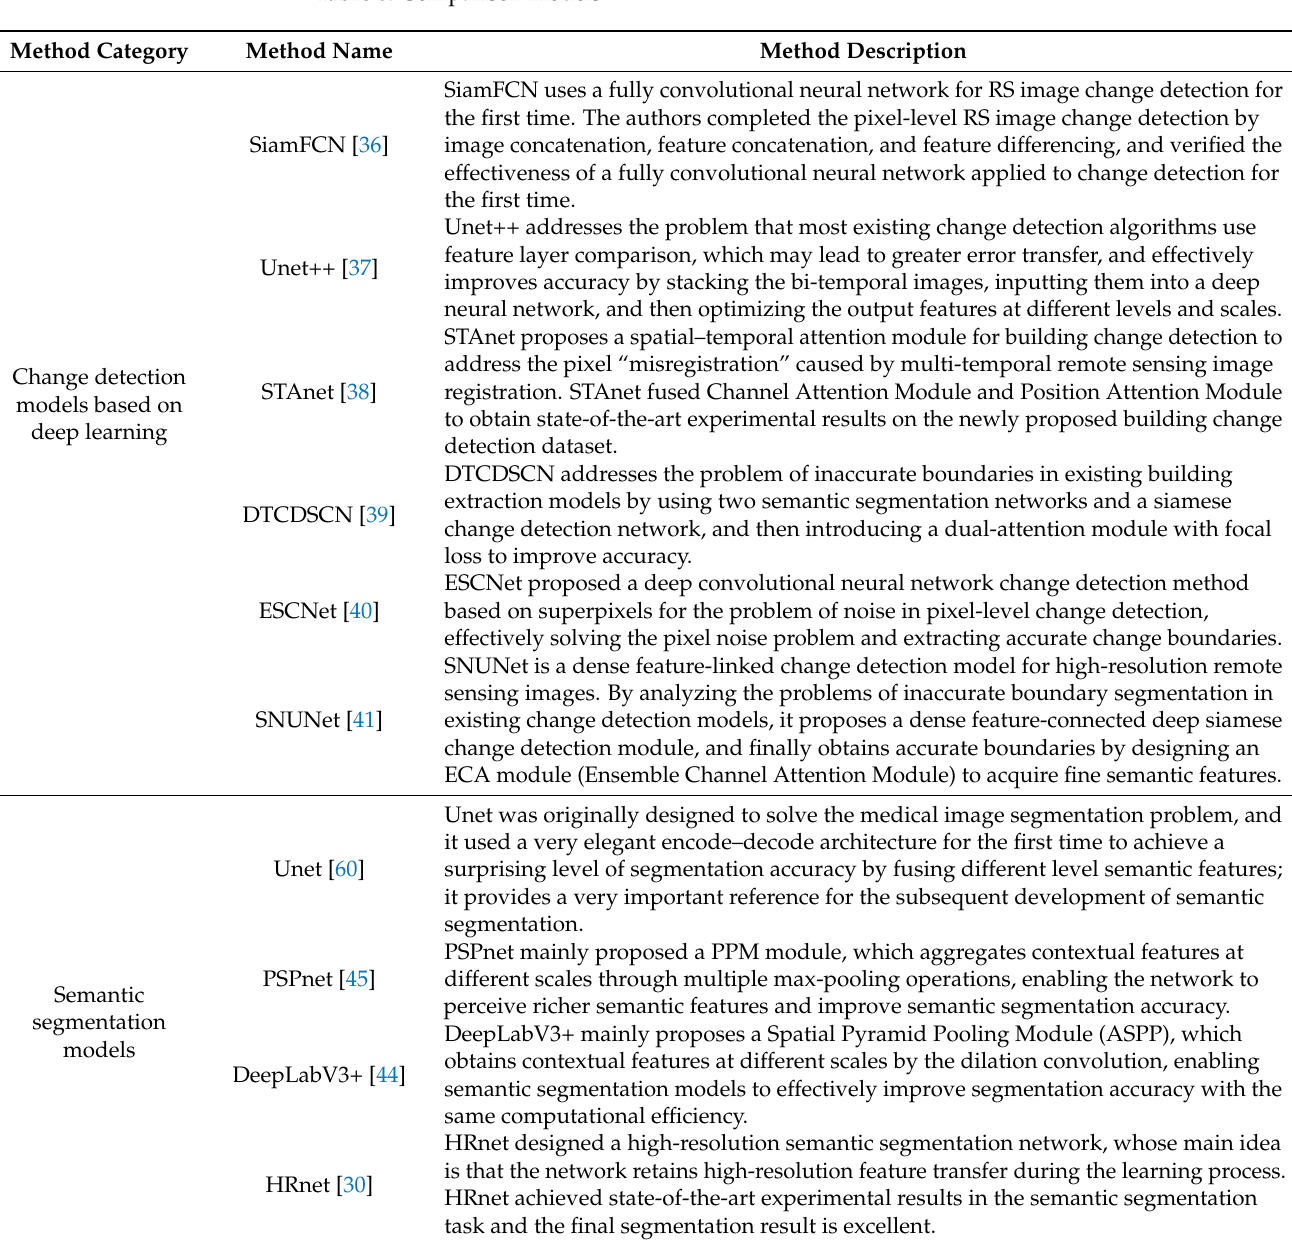
Table 6. Comparison